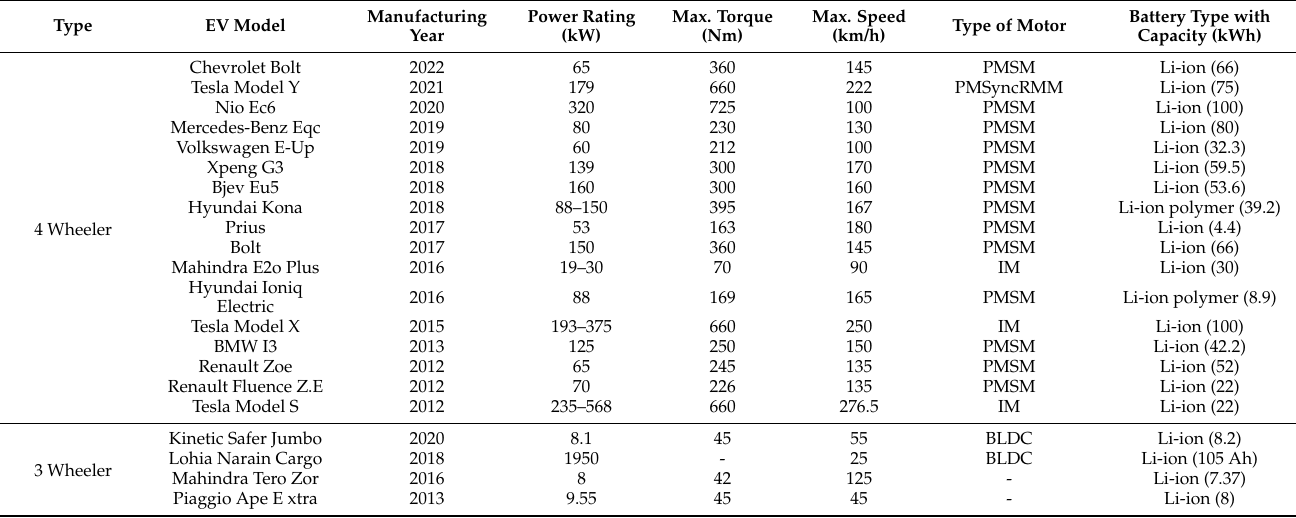
Table 12. Real-time EV